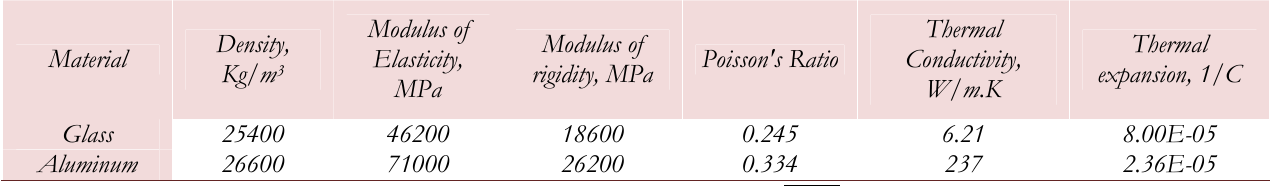
Table 1: Typical property of materials [8, 9].